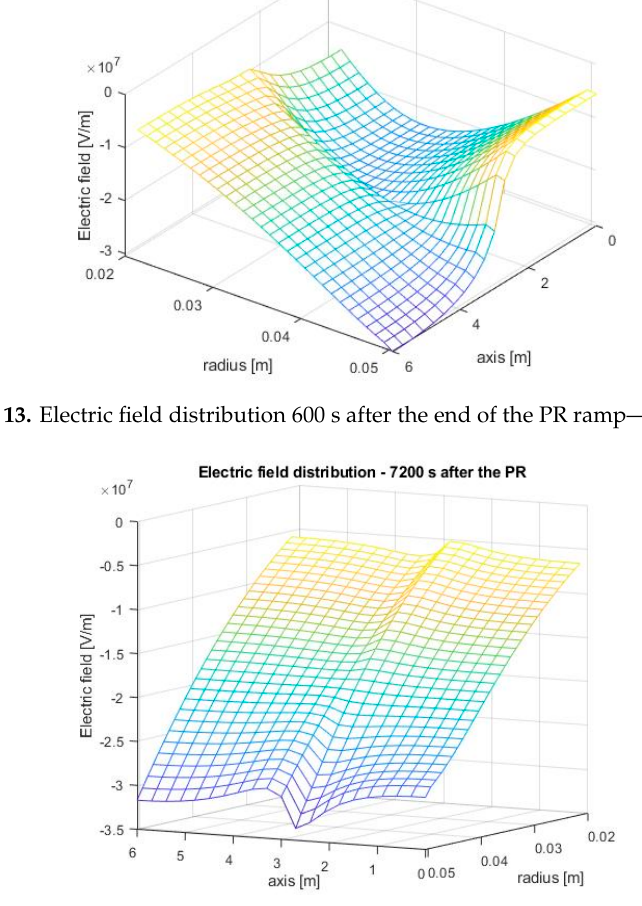
Figure 14. Electric field distribution 7200 s after the end of the PR ramp—Scenario E.